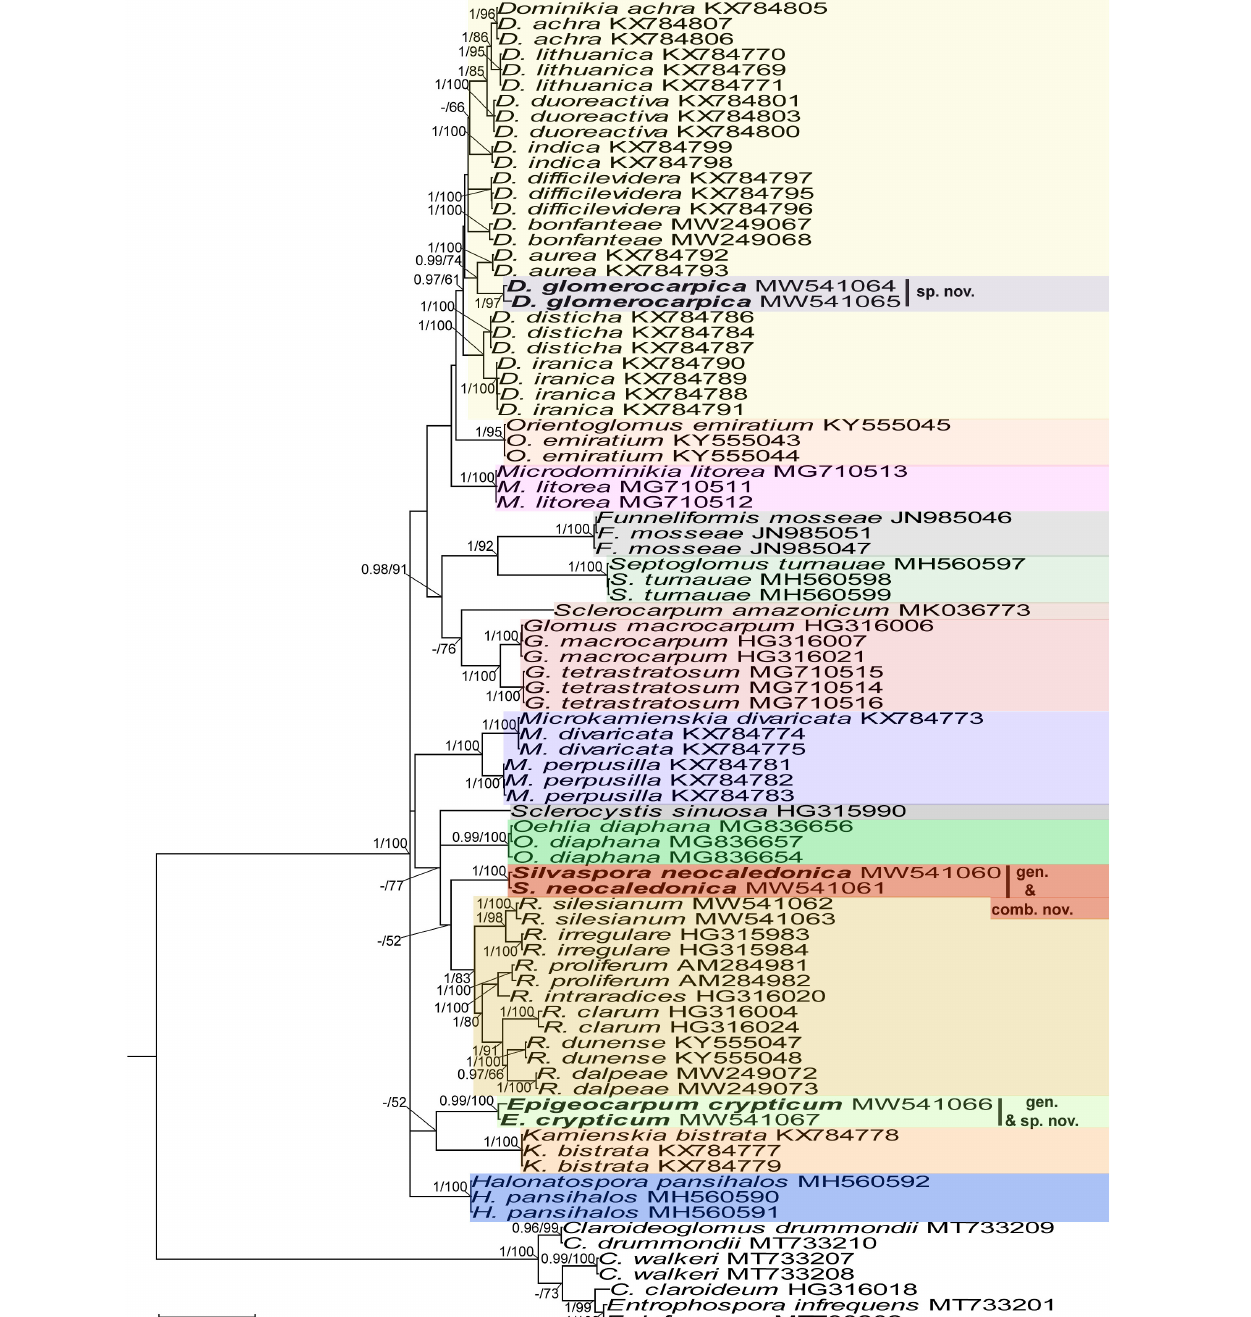
full or high (BI = 1.0, ML = 97% for “Species 1” and BI = 0.99, ML = 100% for “Species 2”; Figures 1 , 3